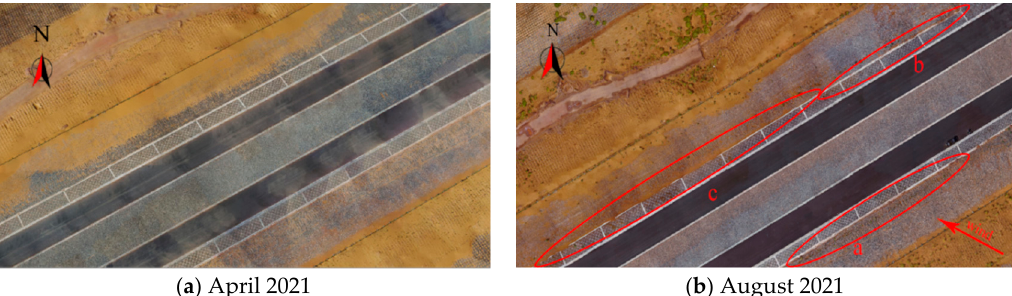
Figure 15. Distribution of on-site sand accumulation at K166+100 of Wuma highway. It can be seen from Figure 15 that the angle between the sand-moving wind direction and the line direction is about 50°. There was basically no sand accumulation on either side of the line in April 2021. In August 2021, it can be seen that there was a small amount of sand at the foot of the windward side slope. There is a lot of sand accumulation at the foot of the slope on the leeward side, and the sand accumulation on the lower side of the line was far more than the sand accumulation on the upper side. Comparing with Figure 6b, it can be found that the two have good consistency. Figure 16 is a map of sand accumulation around the embankment with a curve radius of R = 5500 m. The tangent of the curve is 1048 m. In this paper, only a circular curve with tangent length of 300 m from the center of the circle was selected, and the line direction was on both sides of the embankment at the intersection of the curve, while there was almost no sand accumulation on both sides of the embankment at the starting position of the curve. Considering the influence of wind direction and the angle of the line on the sand accumulation, it can also be seen that the concave curve had a gathering effect on the sand particles, resulting in sand accumulation in the middle of the line. This phenomenon can better verify the sand cloud map of the concave windward embankment.